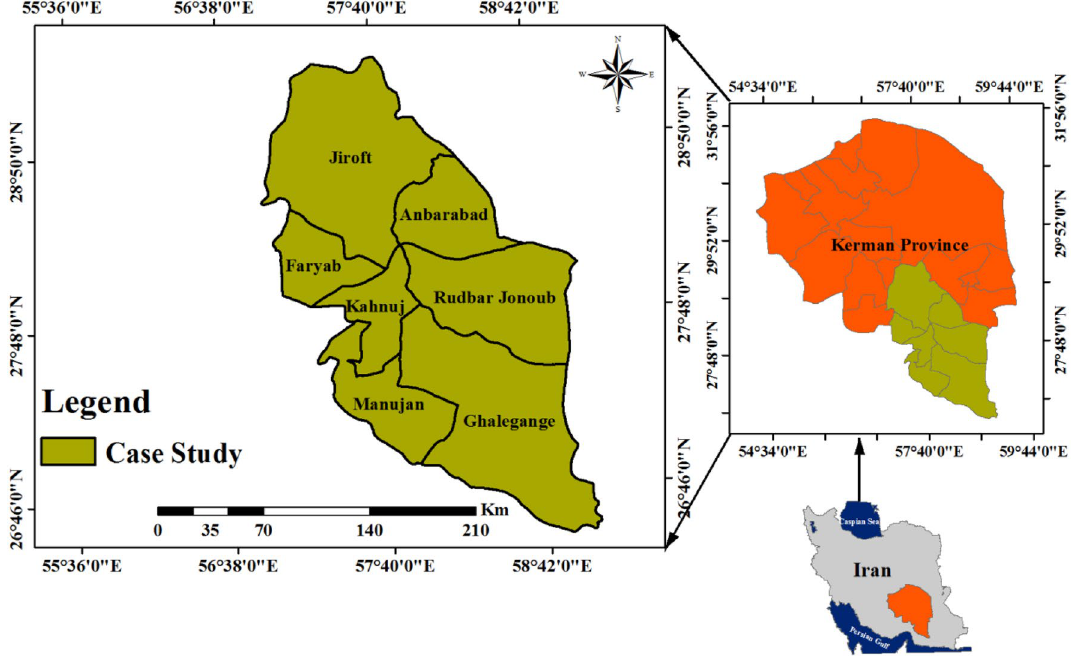
Figure 2. Study Area. ArcGIS software version 10.1 (https:// www. esri. com/ enus/ arcgis/ produ cts/ arcgis- pro/ resou rces) was used to generate the